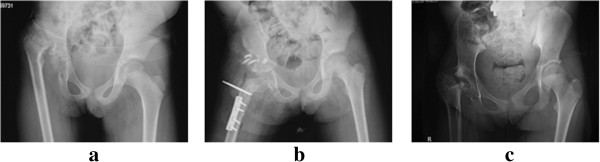
Serial radiographs of an 11-year-old girl who presented with tuberculosis of hip dislocation, thoracolumbar kyphosis, and spinal tuberculosis. She was treated by right open reduction, Dega pelvis osteotomy, and subtrochanteric shortening osteotomy in the left proximal femur. (a) Pre-operative. (b) Immediate post-operative. (c) 2 years post-operative.